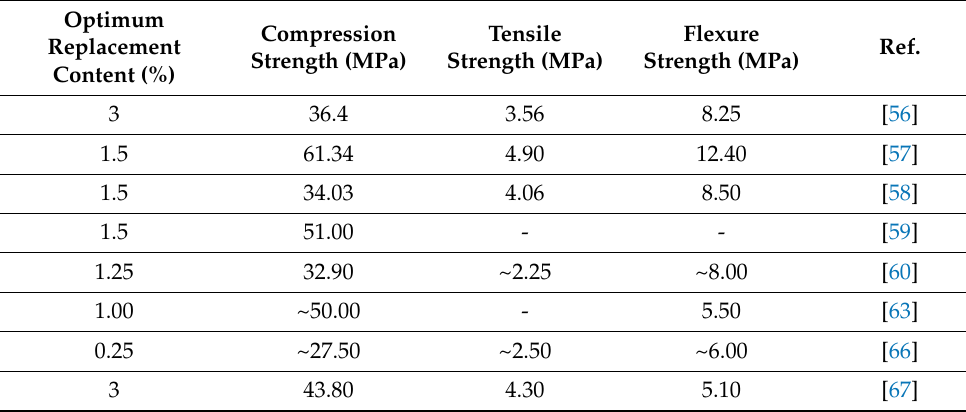
Table 4. Synthesis of the mechanical results of the investigated